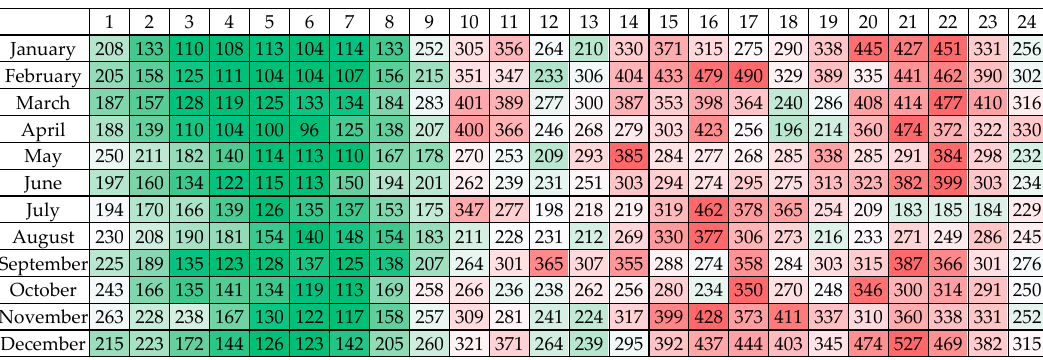
Figure 11. The aggregate profile of average power: Saturdays. (Green: low; White: medium; Red: high).